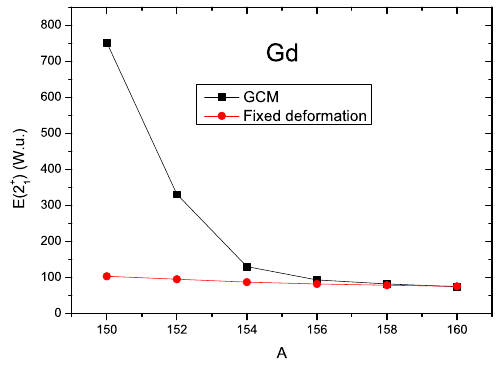
Figure 4. (Color online) Comparison of calculated energy ratio ) for 150 − 160 Gd with the experimental ones. ) / E (2 + E (4 + 1 1